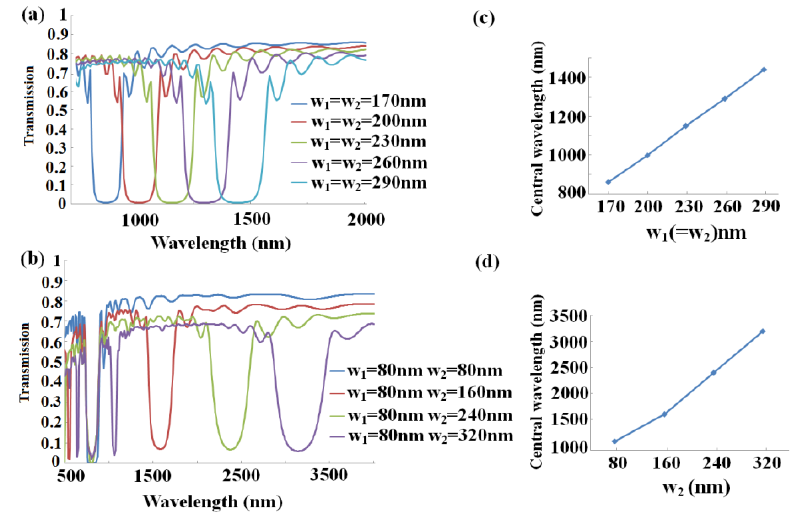
Figure 4. Transmission spectra of the MIM-based sensor as a function of wavelength and the central wavelength as a function of the grating width with n = 8, and h 1 = h 2 = 10 nm ( a ) the transmission spectra with grating width w 1 equal to w 2 and increasing at the same time and ( c ) only with w 2 altering and w 1 = 80 nm being fixed; ( b , d ) the central wavelength as a function of the grating width corresponding to ( a ) and ( c ), respectively.